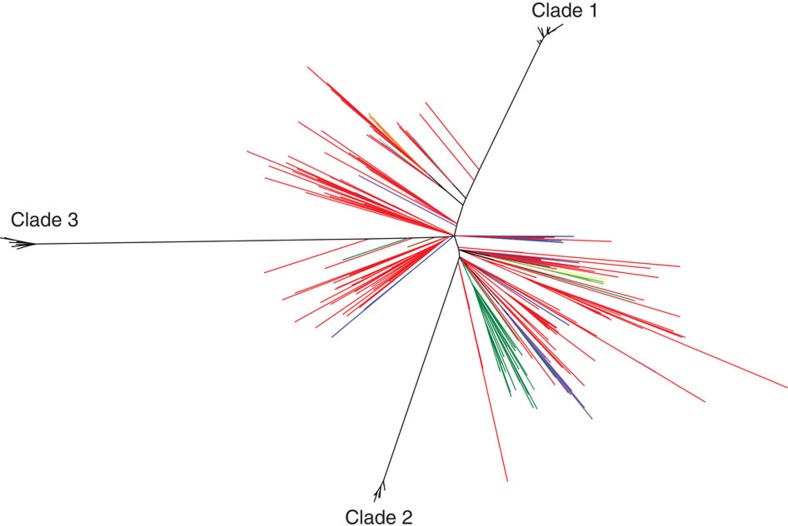
Phylogenetic relationship of three distinct clades of ST22 isolates from the veterinary hospital in comparison to a global collection of ST22 isolates1339.Isolates are coloured according to country of origin. UK=red, Germany=dark green, Australia=dark blue, Portugal=Purple, Denmark=light blue, Czech republic=light green, Sweden=brown, Nigeria=maroon, Hungary=yellow, Singapore=yellow and New Zealand=pink.